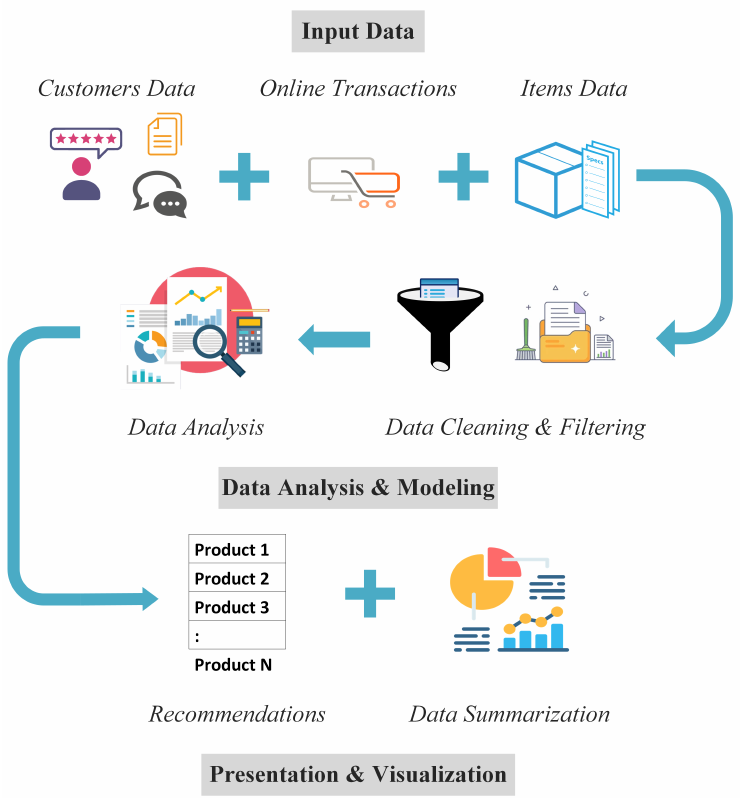
Figure 1. General architecture of a recommender